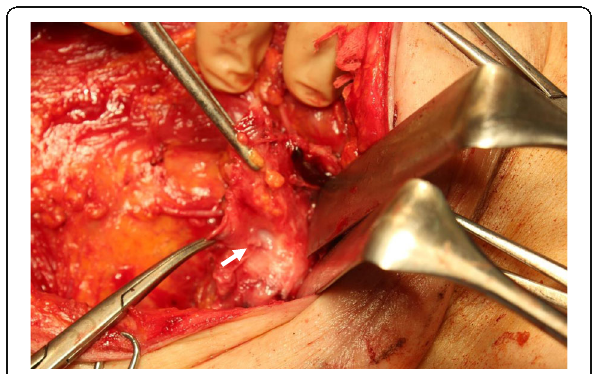
Fig. 4 Operative findings. The white arrow indicates ligation of the opening; the black arrow indicates the 2nd intercostobrachial